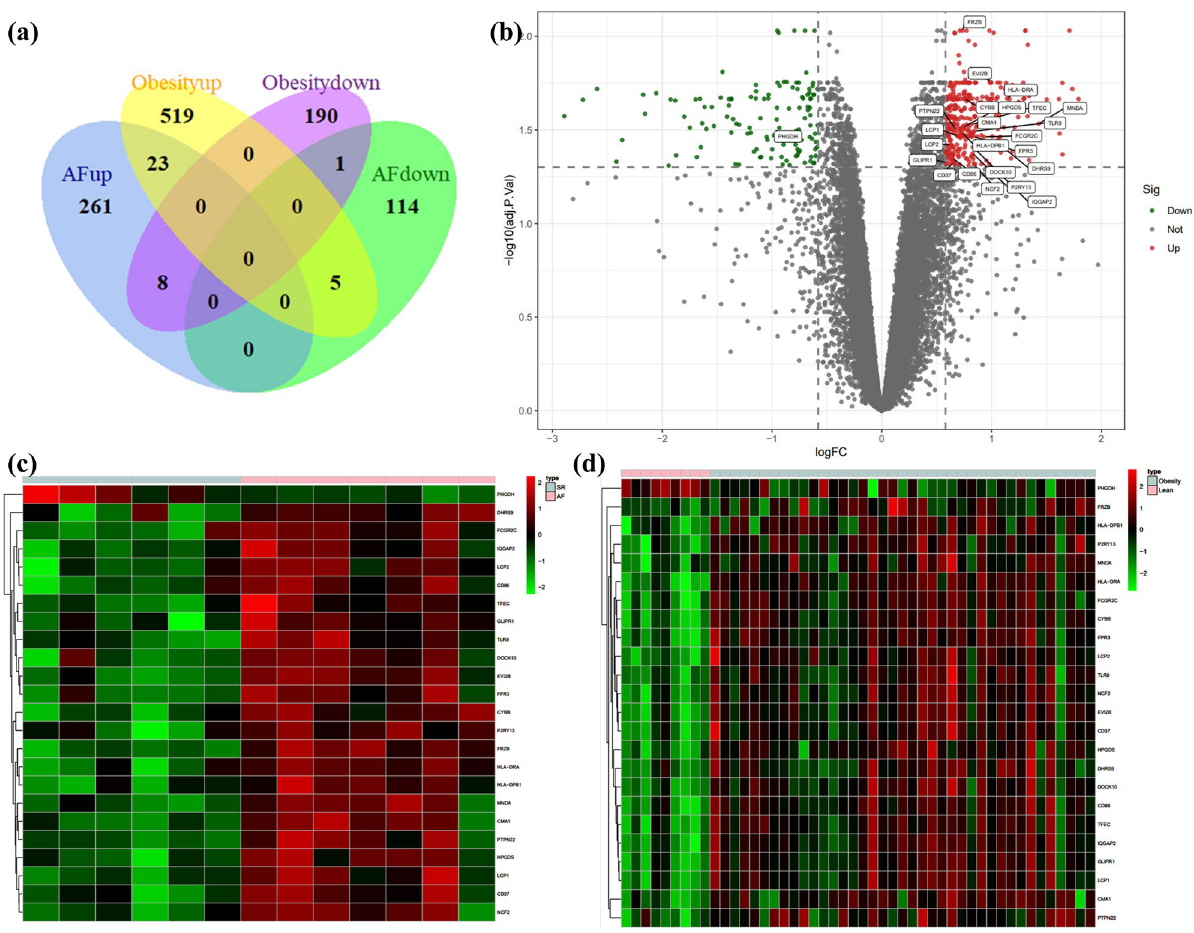
Figure 2. Venn diagram, volcano plot, and heat map of AF- and obese-related DEGs. ( a ) Venn diagram of DEGs related to AF and obesity. ( b ) Volcano plot of DEGs related to AF. Gray points represent the adjusted p -value > 0.05; red points represent adjusted p -value > 0.05 and up-regulated genes; green points represent adjusted p -value < 0.05 and down-regulated genes. ( c ) Heat map of GSE79768 with co-DEGs related to AF and obesity. The vertical axis represents samples, and the horizontal axis represents co-DEGs. Pink, AF samples; blue, SR samples; red, greater expression; green, less expression. ( d ) Heat map of GSE94752 with co-DEGs related to AF and obesity. Pink, obese samples; blue, lean samples; red, greater expression; green, less expression.